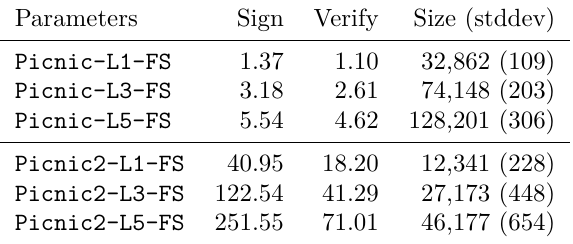
Table 1: Baseline benchmarks of the optimized Picnic implementation used in this work. Sign and verify times are in milliseconds and signature sizes are in bytes. The average signature size of 1000 signatures is given along with the standard deviation.